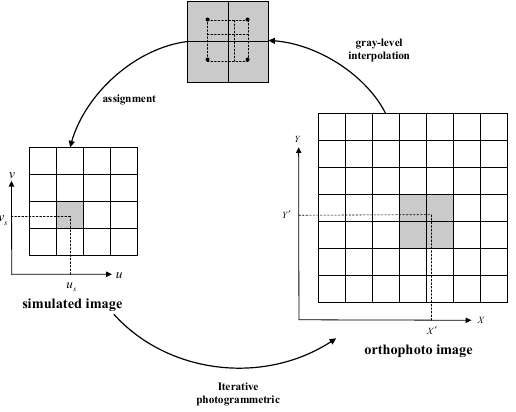
Figure 4. UAV image generation process.